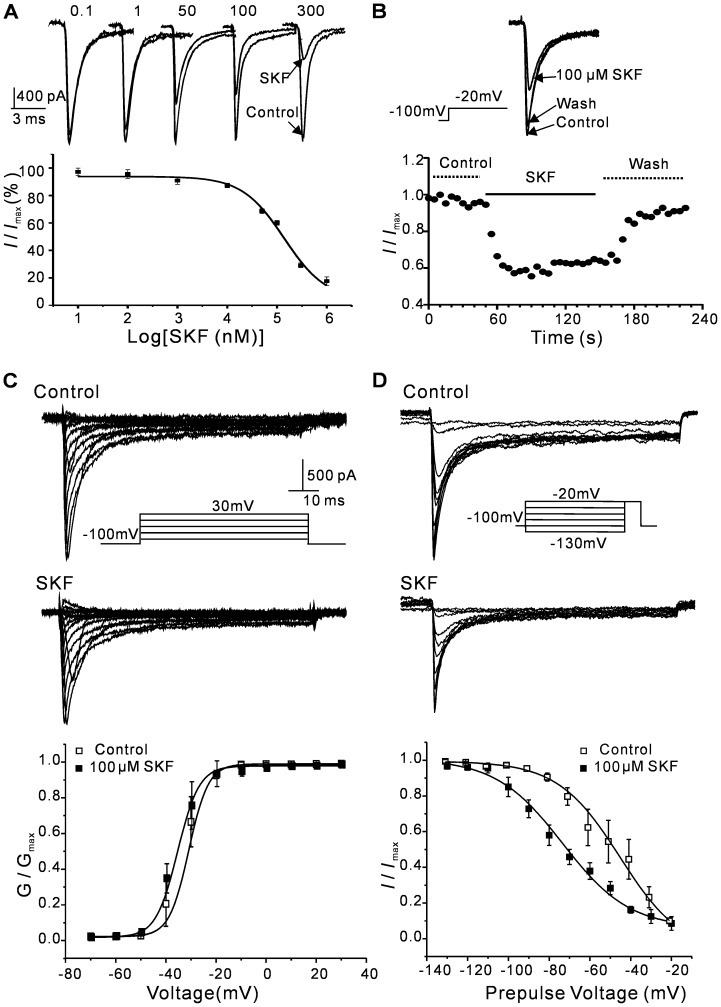
(+)-SKF 10047 inhibition of the NaV1.2 current in transfected HEK293T cells.A, representative current traces of NaV1.2 current blocked by various concentrations of (+)-SKF 10047 (0.1∼300 µM, top). The currents were elicited by a test pulse of −20 mV from a holding potential of −100 mV. The dose-response curve was fitted using the equation given in methods. The half-maximal inhibition value was 140 µM and the Hill coefficient was −1.0. (bottom). B, A sample current shows the reversible 100 µM (+)-SKF 10047 inhibition of the NaV1.2 current (top). The time course of the NaV1.2 current inhibition by 100 µM (+)-SKF 10047 (bottom). C, The effect of (+)-SKF 10047 on steady-state activation of NaV1.2 . The current traces show the voltage-dependent NaV1.2 current activation curves in the absence (top) and presence (middle) of (+)-SKF 10047; the normalized data points were fitted using the Boltzmann equation (bottom). (+)-SKF 10047 did not alter the steady-state NaV1.2 activation. P>0.05, n = 5. D, The effect of (+)-SKF 10047 on steady-state inactivation of NaV1.2. The control currents (top) and currents following treatment with 100 µM (+)-SKF 10047 (middle) are shown. The normalized data points were fitted using the Boltzmann function (bottom).